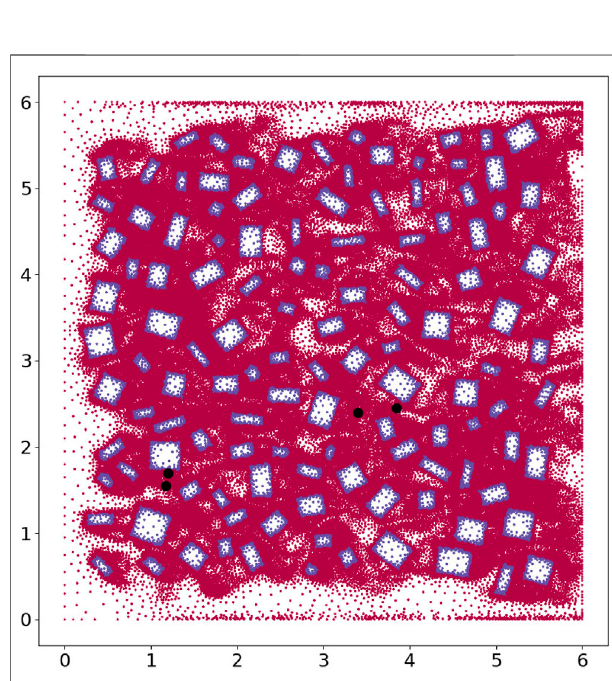
FIGURE 8 | Here we plot all the nodes within the 6 by 6 domain. The nodes within the building appear as blue and those outside of the building as red. We also show four points within the domain, in black, where we plot the histograms, or probability density functions, of the x − and y − components of